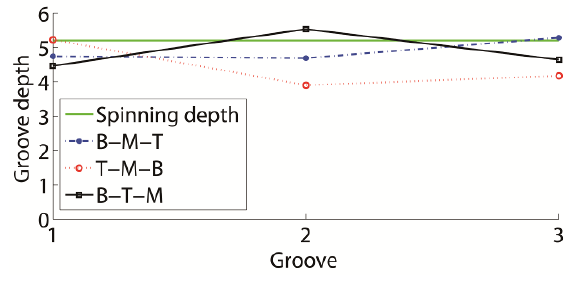
Figure 17. Effect of spinning sequence on groove depth.